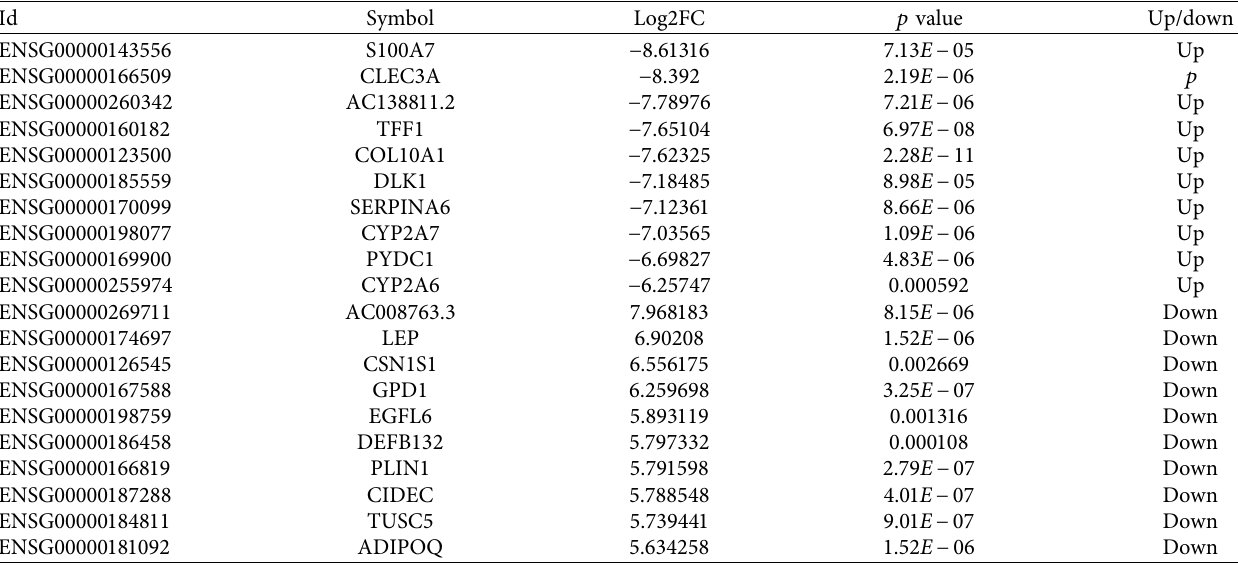
Table 2: Top 20 DEmRNAs in luminal A breast cancer.